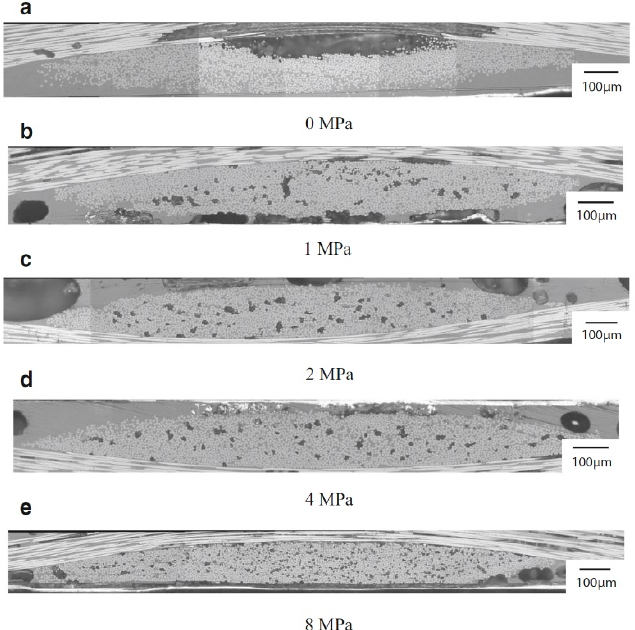
Figure 6. Cross section of CFF-PI laminate as a function of mould pressure: ( a ) 0 MPa, ( b ) 1 MPa, ( c ) 2 MPa, ( d ) 4 MPa, and ( e ) 8 MPa. Reprinted with permission from Reference [32].